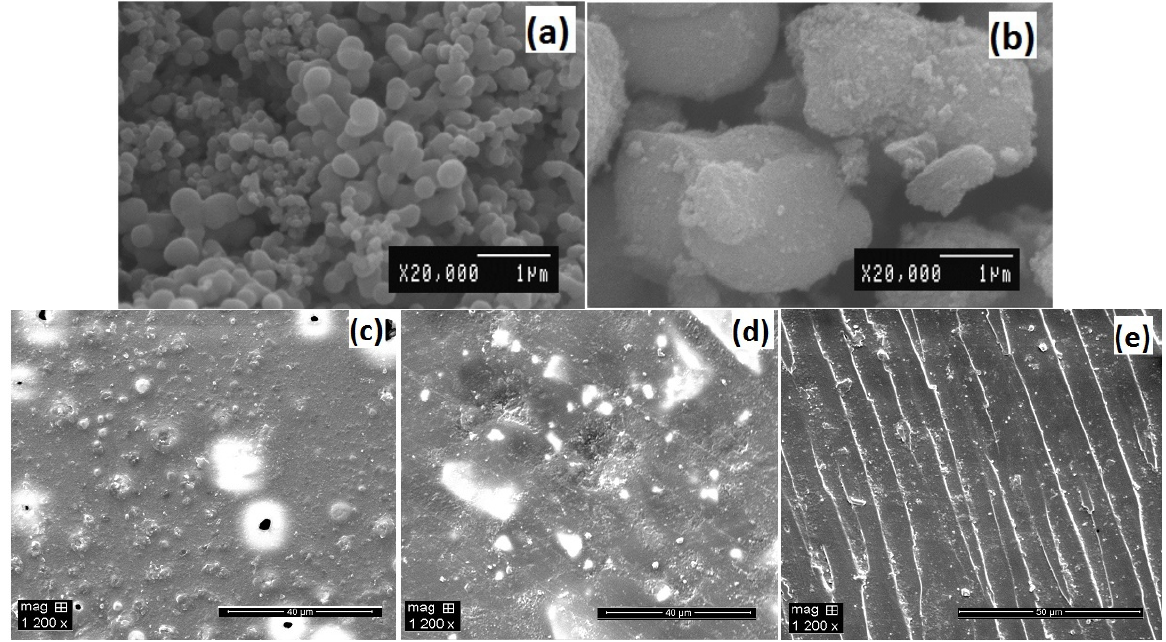
Figure 4. Scanning electron microscopic (SEM) characterization of ( a ) sol-gel synthesized TiO 2 ; ( b ) 1.5 wt% silver doped TiO 2 ; ( c ) 1 wt% epoxy/TiO 2 composite; ( d ) 1 wt% epoxy/Ag-TiO 2 composite; ( e ) Fractured surface of 1 wt% epoxy/Ag-TiO 2